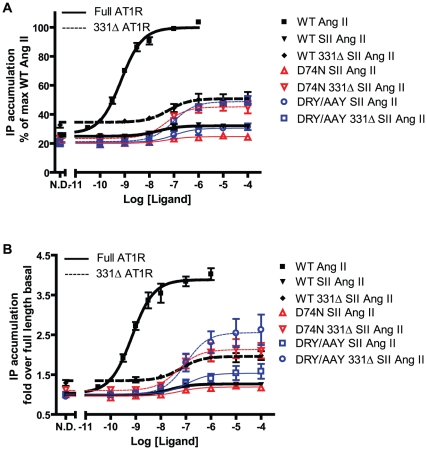
SII Ang II induced IP accumulation.
A: Dose-response curves normalized to the fitted maximum response for WT AT1R compiled from at least 3 independent experiments performed in triplicates (mean and S.E.M.). B: Dose-response curves normalized to no drug (N.D.) response for the full length receptor. In this graph, one data set for DRY/AAY 331Δ had to be left out due to missing values for full length DRY/AAY on that particular assay date. Experimental setup as in figure 5.